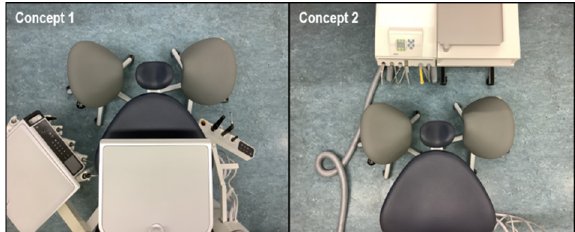
Figure 1. Dental treatment concepts 1 and 2. In both illustrated dental treatment concepts, dentists treat on the left chair (9 o’clock), while dental assistants treat on the right chair (3 o’clock). In treatment concept 1, the functional area is divided, while in treatment concept 2, dentist and assistant share the same functional area.